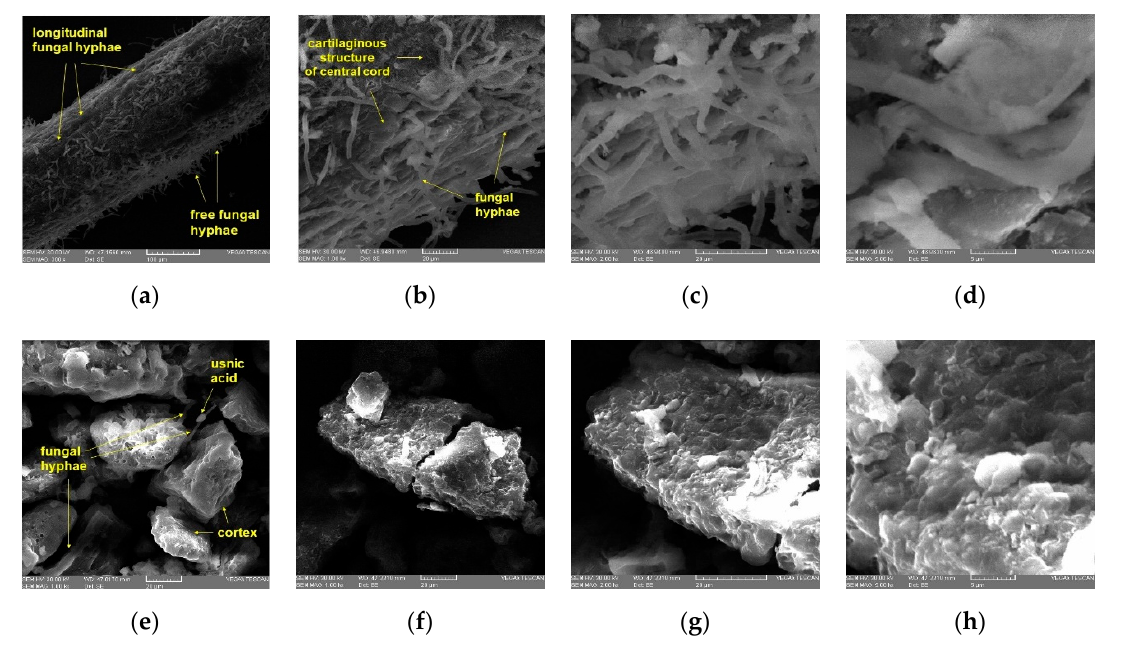
Figure 3. ( a – d ) Microstructure of the central cord ( cc UB) with particle size > 315 μ m, in SEM images with different magnifications: ( a ) 300× (scale bar = 100 μ m), ( b ) 1 k× (scale bar = 20 μ m), ( c ) 2 k× (scale bar = 20 μ m), ( d ) 5 k× (scale bar = 5 μ m); ( e – h ) SEM micrographs of mc UB (medulla–cortex) with particle size ≤ 315 μ m: ( e ) cortex parts with rare fungal hyphae on the surface, 1 k× (scale bar = 20 μ m), ( f – h ) cortex fragment at different magnifications: ( f ) 1 k× (scale bar = 20 μ m), ( g ) 2 k× (scale bar = 20 μ m), ( h ) 5 k× (scale bar = 5 μ m).